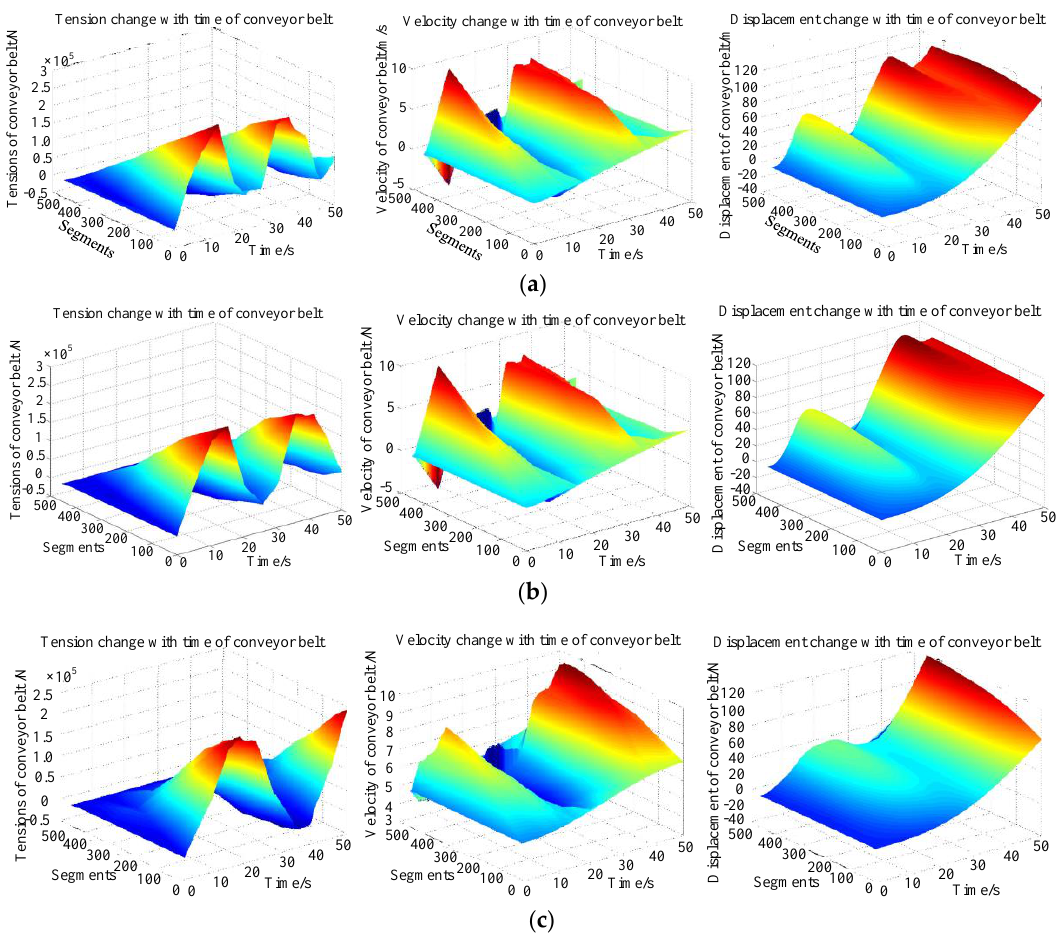
Figure 10. Dynamic characteristic curves of the belt conveyor. ( a ) Empty-load. ( b ) Light-load. ( c ) Figure10. Dynamiccharacteristiccurvesofthebeltconveyor. ( a )Empty-load. ( b )Light-load. ( c Over-load.